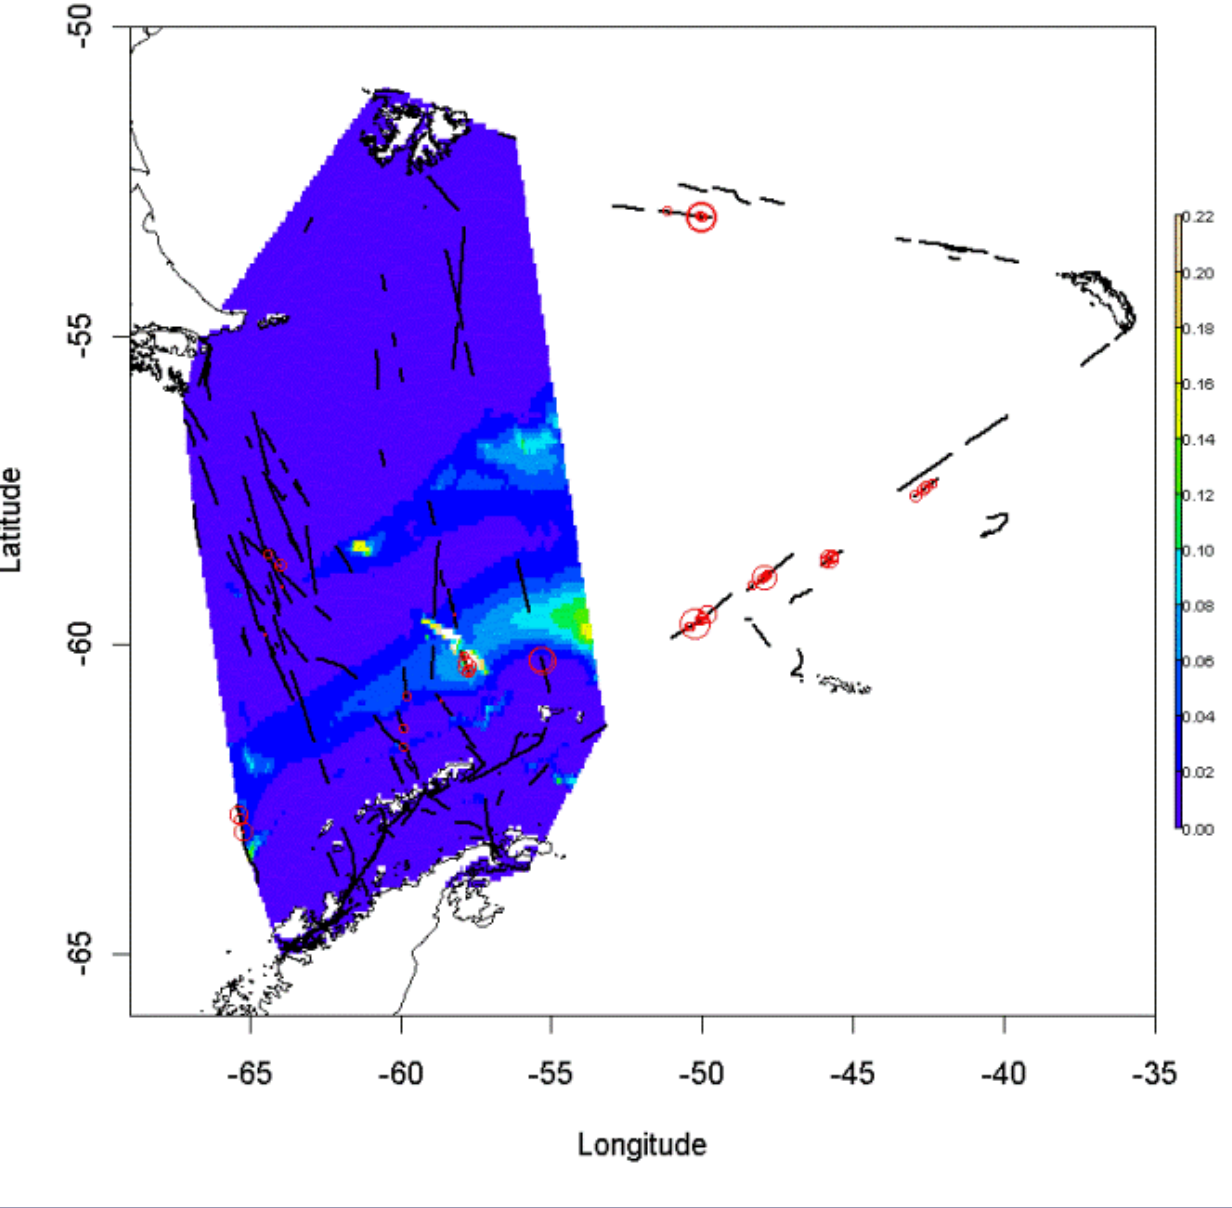
Fig. 4. Predicted density gradient of fin whale schools in the best-covered region of the study area. The scale bar on the right is in units of schools per nm 2 . Tracklines are shown as solid black lines, and fin whale sightings are shown as red circles with radius proportional to school